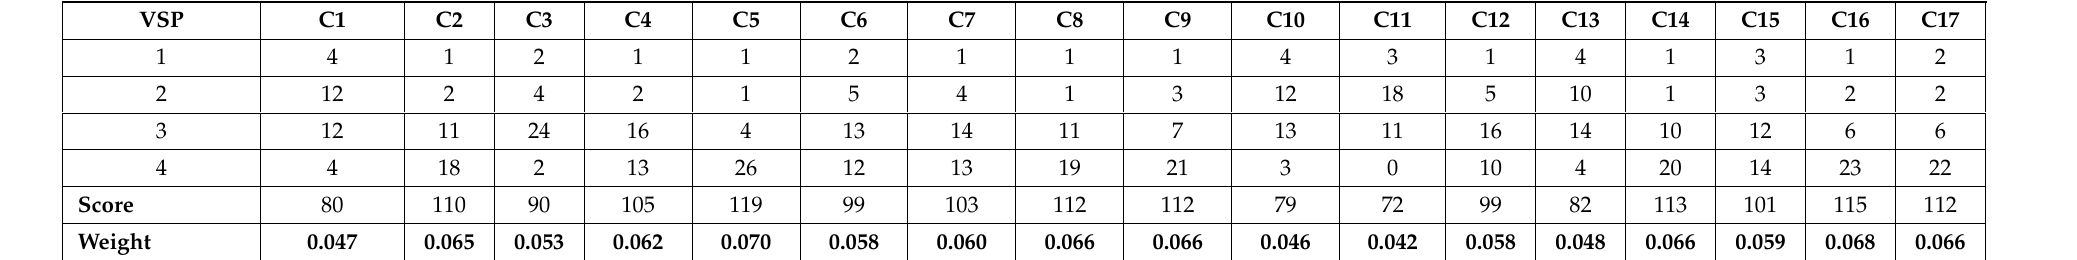
Table 4. Matrix about the weights of the